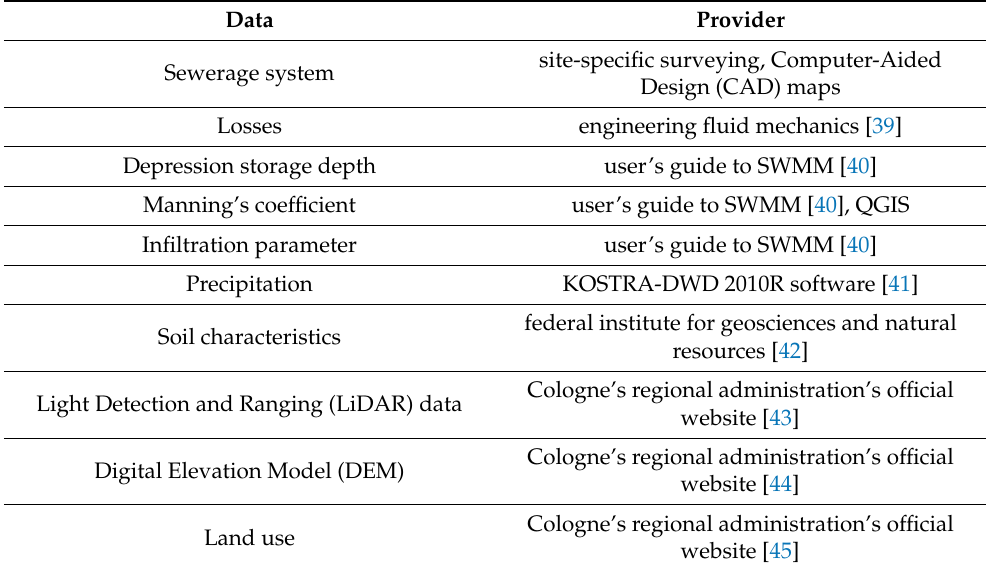
Table 1. An overview of data